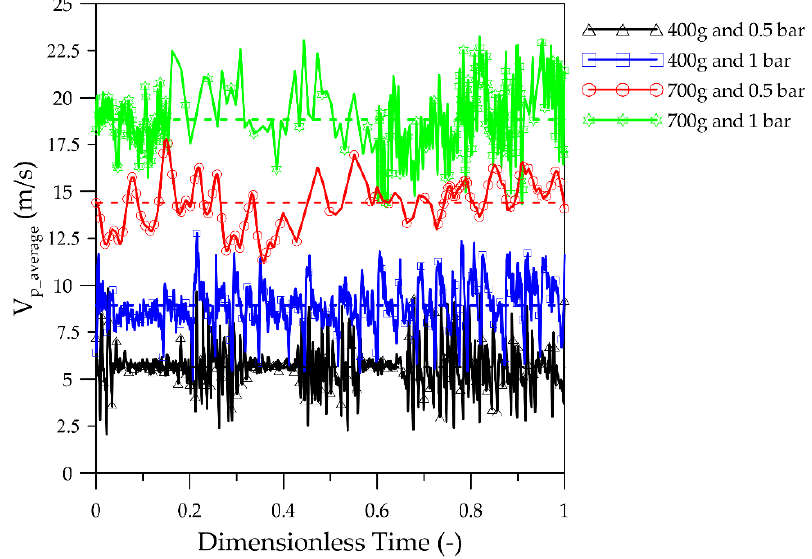
Figure 4. Temporal distribution of the volumetric particle velocity (calculated through Equation (27)) as a function of the solid holdup and the nozzle inlet pressure.